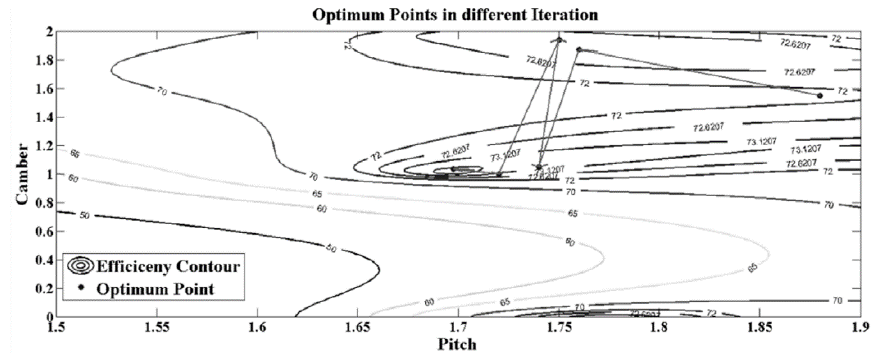
Figure 27. The convergence procedure of the optimization [107].